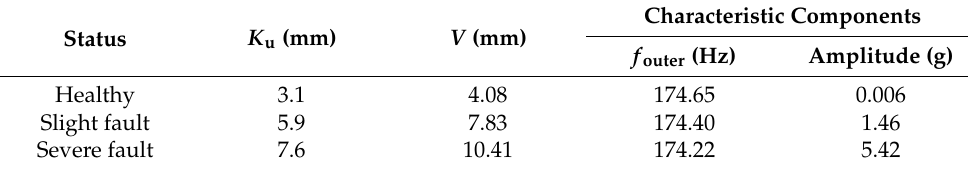
Table 4. Bearing outer race fault diagnosis results of the Y100L-2 motor with a full load.